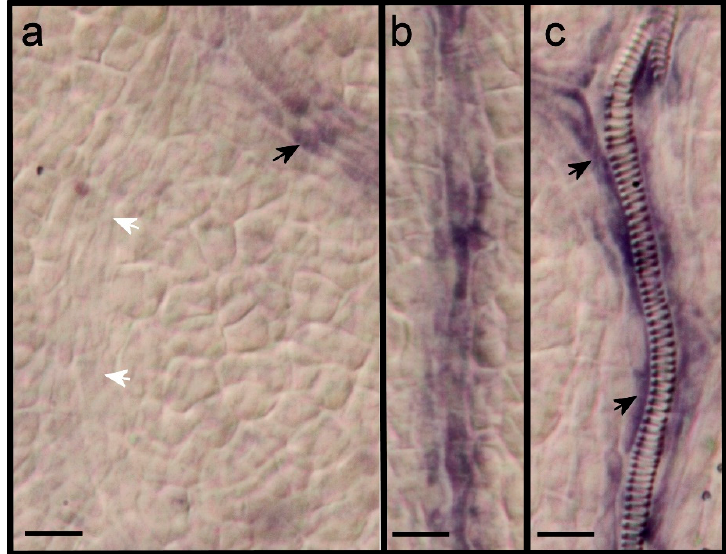
Figure 3. Expression of ARF7 during vein differentiation. ( a ) Expression in older procambial secondary vein (black arrow) but not in younger, more basal, procambial secondary vein (white arrows), ( b ) expression in procambial secondary vein, ( c ) expression in elongated cells flanking a differentiating vessel element (back arrows). Size bars, 20 µm.